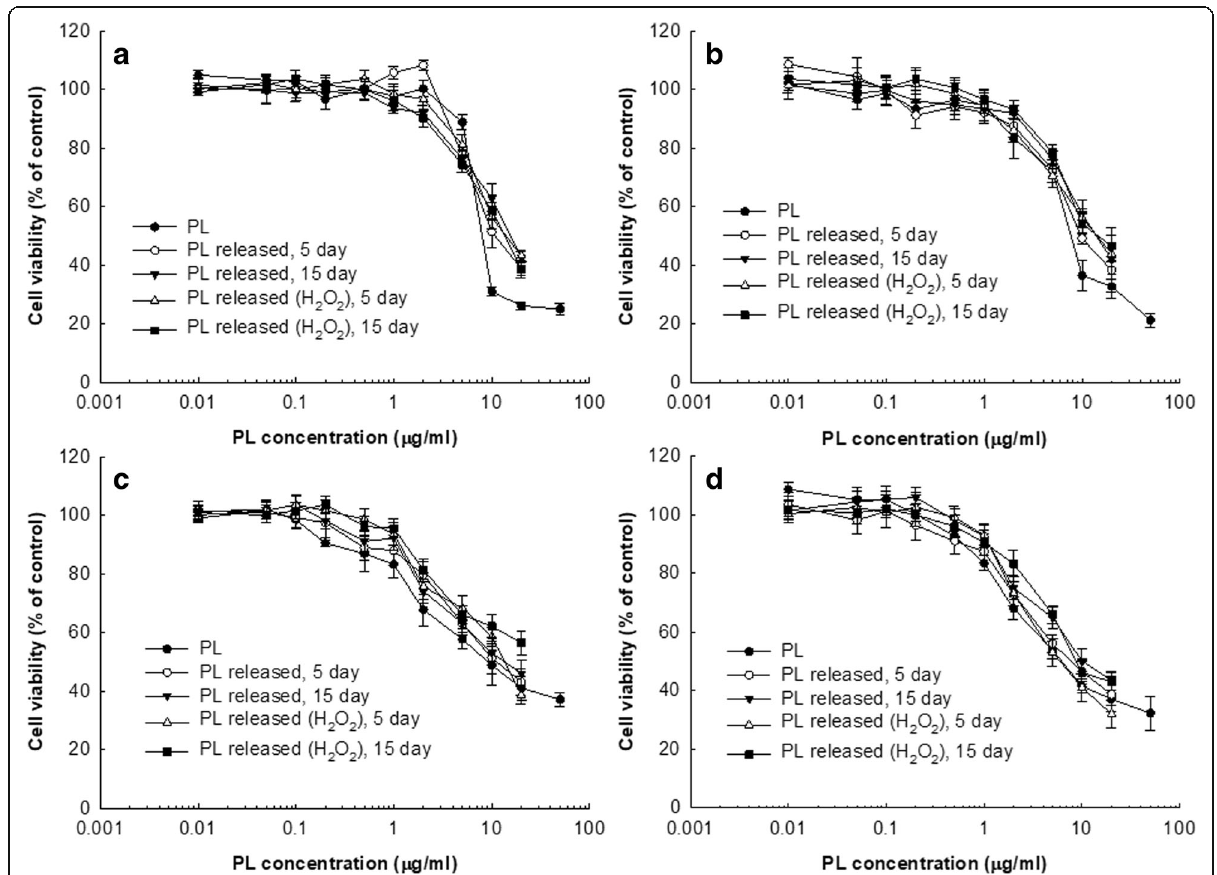
Fig. 4 The effect of PL and released PL from nanofiber mats on the viability of various CCA cells. a HuCC-T1, b SNU1196, c SNU478, and d SNU245 cholangiocarcinoma cells. 2 × 10 4 cells in 96-well plates were exposed to PL or released PL from nanofibers for 2 days. For treatment of released PL, PL-incorporated nanofiber disks were immersed into PBS and then release experiment was performed for 5 and 15 days with or without 10 mM H 2 O 2 . The medium was exchanged until 3 days as similar with drug release study. After that, the medium was harvested between 5 and 15 days of release experiment. This solution was used to investigate the comparison of anticancer activity of PL itself and released